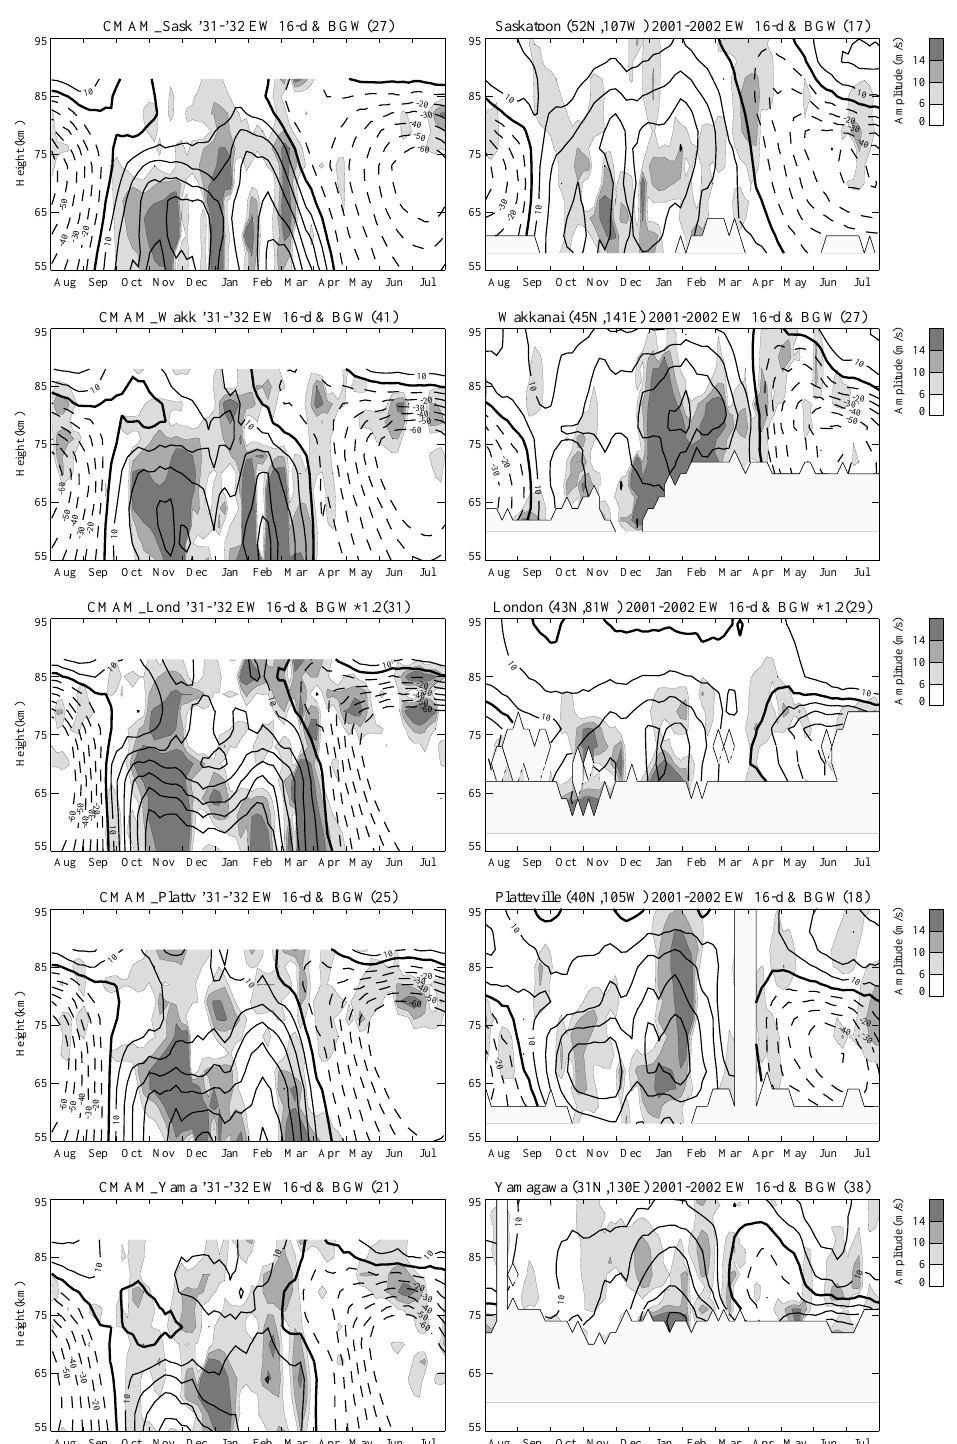
Fig. 11. Amplitudes of the 16-d planetary wave (NS and EW) resulting from a Fourier analysis (bandwidth 13–19 days; 48-day window length shifted in 5-day steps over the year) of CMAM data (model-years 31/32) and of MF radar data (years 2001/02). For each window- length the mean (48-day) is removed and used to represent the background wind: continuous lines for eastwards winds, dashed lines for the westward. The locations are Saskatoon, Wakkanai, London and Platteville. Data amplitudes from London’s MFR are multiplied by a factor of 1.2 due to a bias in the local analysis. The number in brackets at the top of each panel gives the maximum value found in those